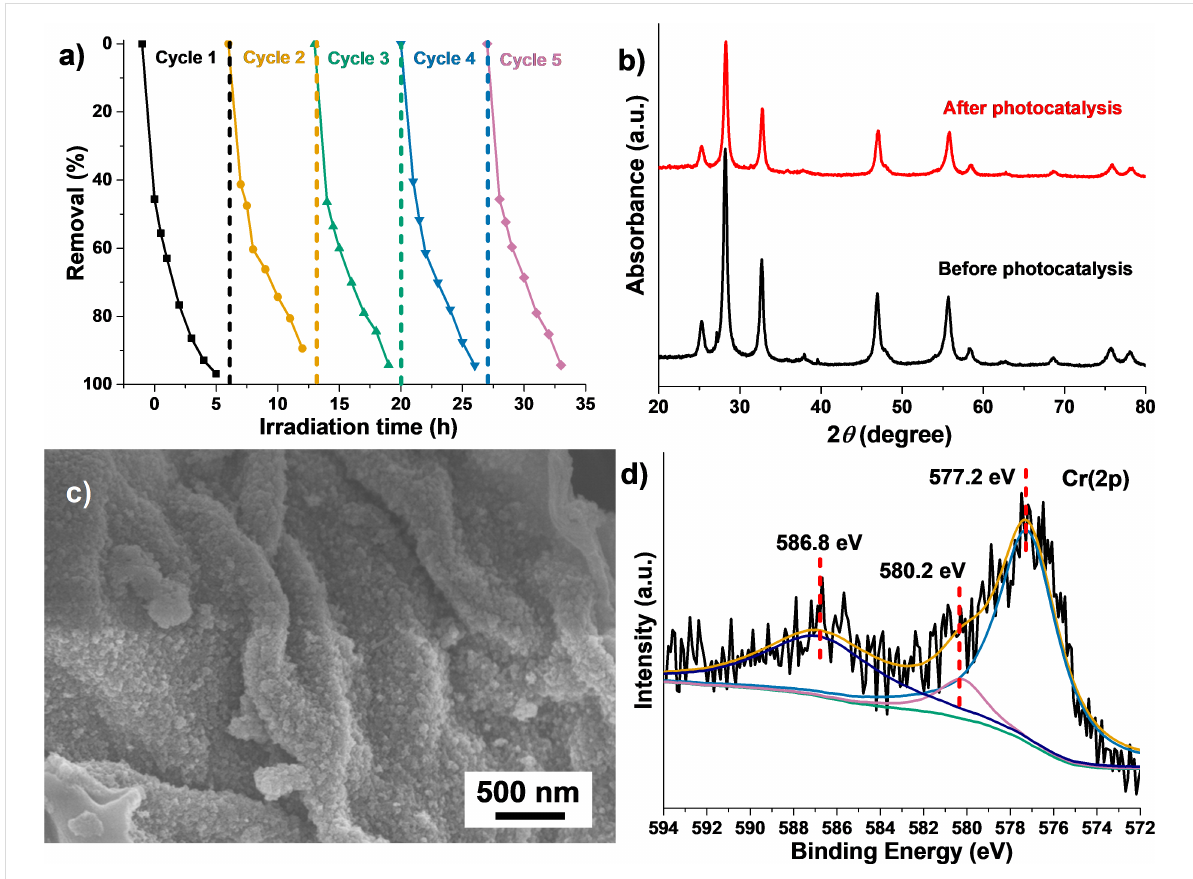
Figure 8: (a) The visible-light-induced ( λ > 420 nm) photocatalytic reduction profiles toward the Cr (VI) pollutant solution (10 mg·L − 1 , pH 4) for five cycles by the hierarchical 70% − Bi 2 WO 6 /TiO 2 -NT nanocomposite. (b) XRD patterns of the 70% − Bi 2 WO 6 /TiO 2 -NT nanocomposites before and after five-cycle photocatalysis. (c) The FE-SEM image and (d) high-resolution XPS spectrum of the Cr 2p region of the 70% − Bi 2 WO 6 /TiO 2 -NT nanocom- posite after five-cycle